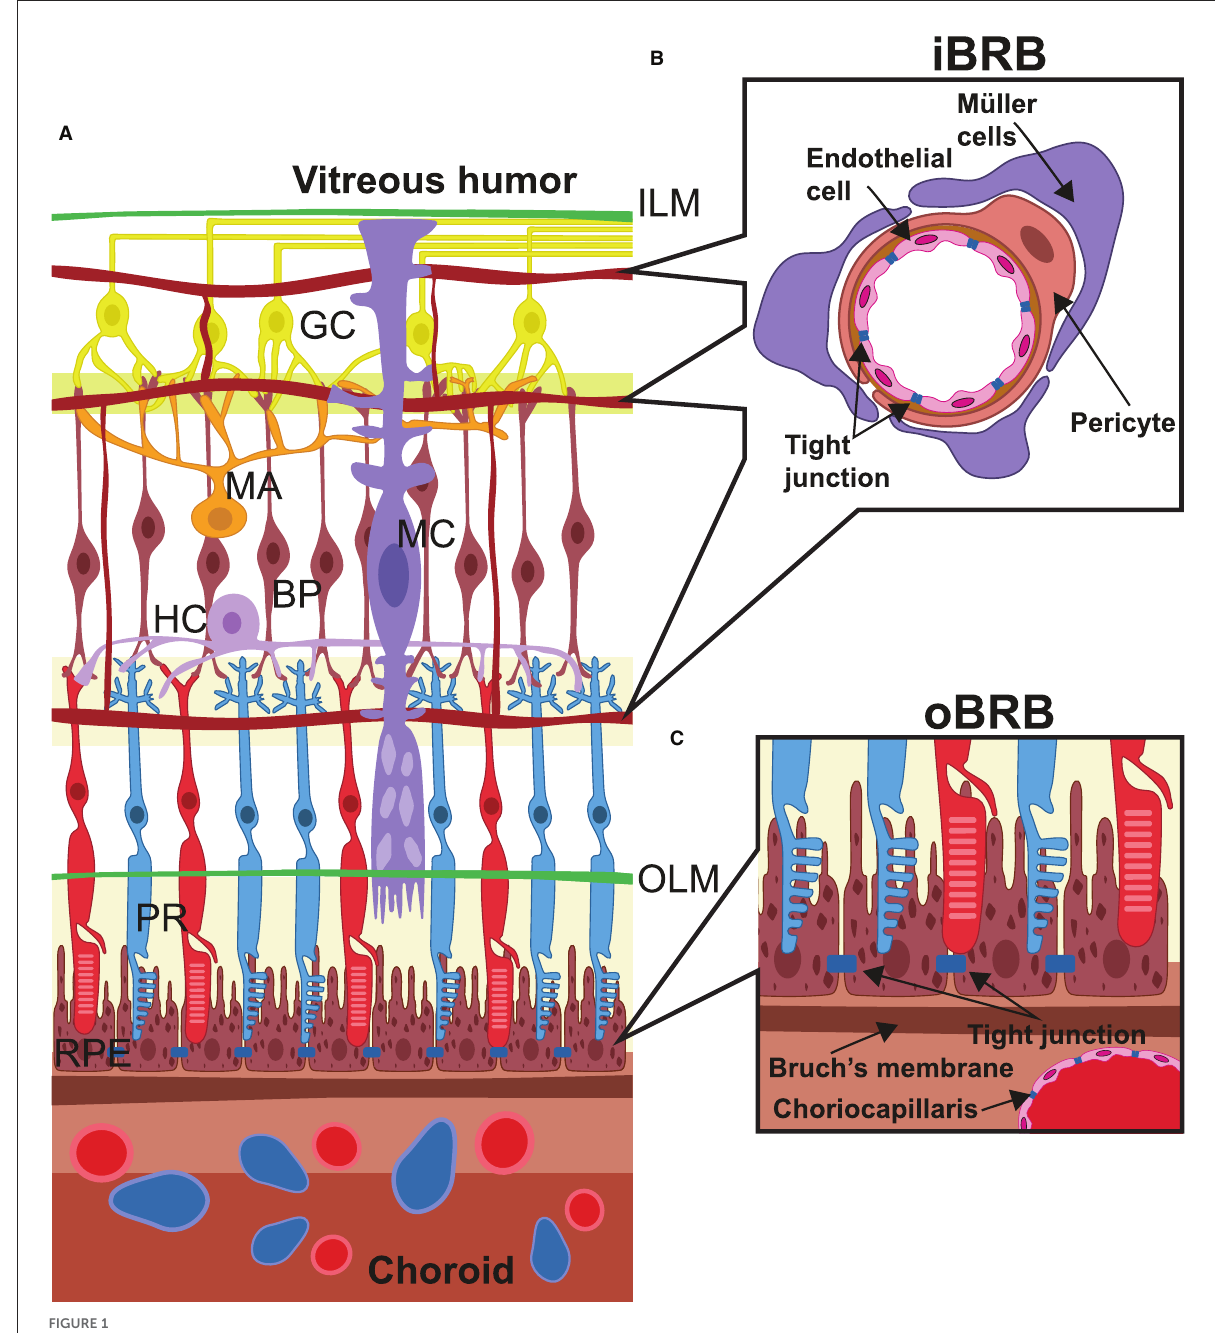
FIGURE1 Retinal microanatomy and blood–retina barriers. (A) This image depicts the retinal structure situated in between the internal limiting membrane (ILM) and the choroidal layer (choroid), which externally lines the retinal pigment epithelium (RPE) cells. Over the RPE layer, neurons cross the whole retinal thickness and are radially connected (PR, photoreceptors; BP, bipolar cells; GC, ganglion cells). Other neural cells are amacrine cells (MA), horizontal cells (HC), and Müller cells (MC), which, in particular, terminate at the level of the outer limiting membrane (OLM). Vessels derived from the central retina artery form three different capillary beds were placed alongside the layers of nerve/ganglion layer, internal plexiform, and outer plexiform and interconnected by arterioles and capillaries. In (B) , the structure of the internal blood–retina barrier is given in detail, which consists of several histological elements: the adherent and tight junctions among the capillaries, the pericyte layers around endothelial cells, and extensions from the Müller cells, all of which take part in the control of metabolites and liquid exchange and endothelial proliferation. In (C) , the structure of the outer blood–retina barrier (oBRB) is represented and made from Bruch’s membrane and the RPE layer, which play a pivotal role in controlling several parameters including internal pressure and ocular shape, oxygen exchange, and recycling of materials from the photoreceptor